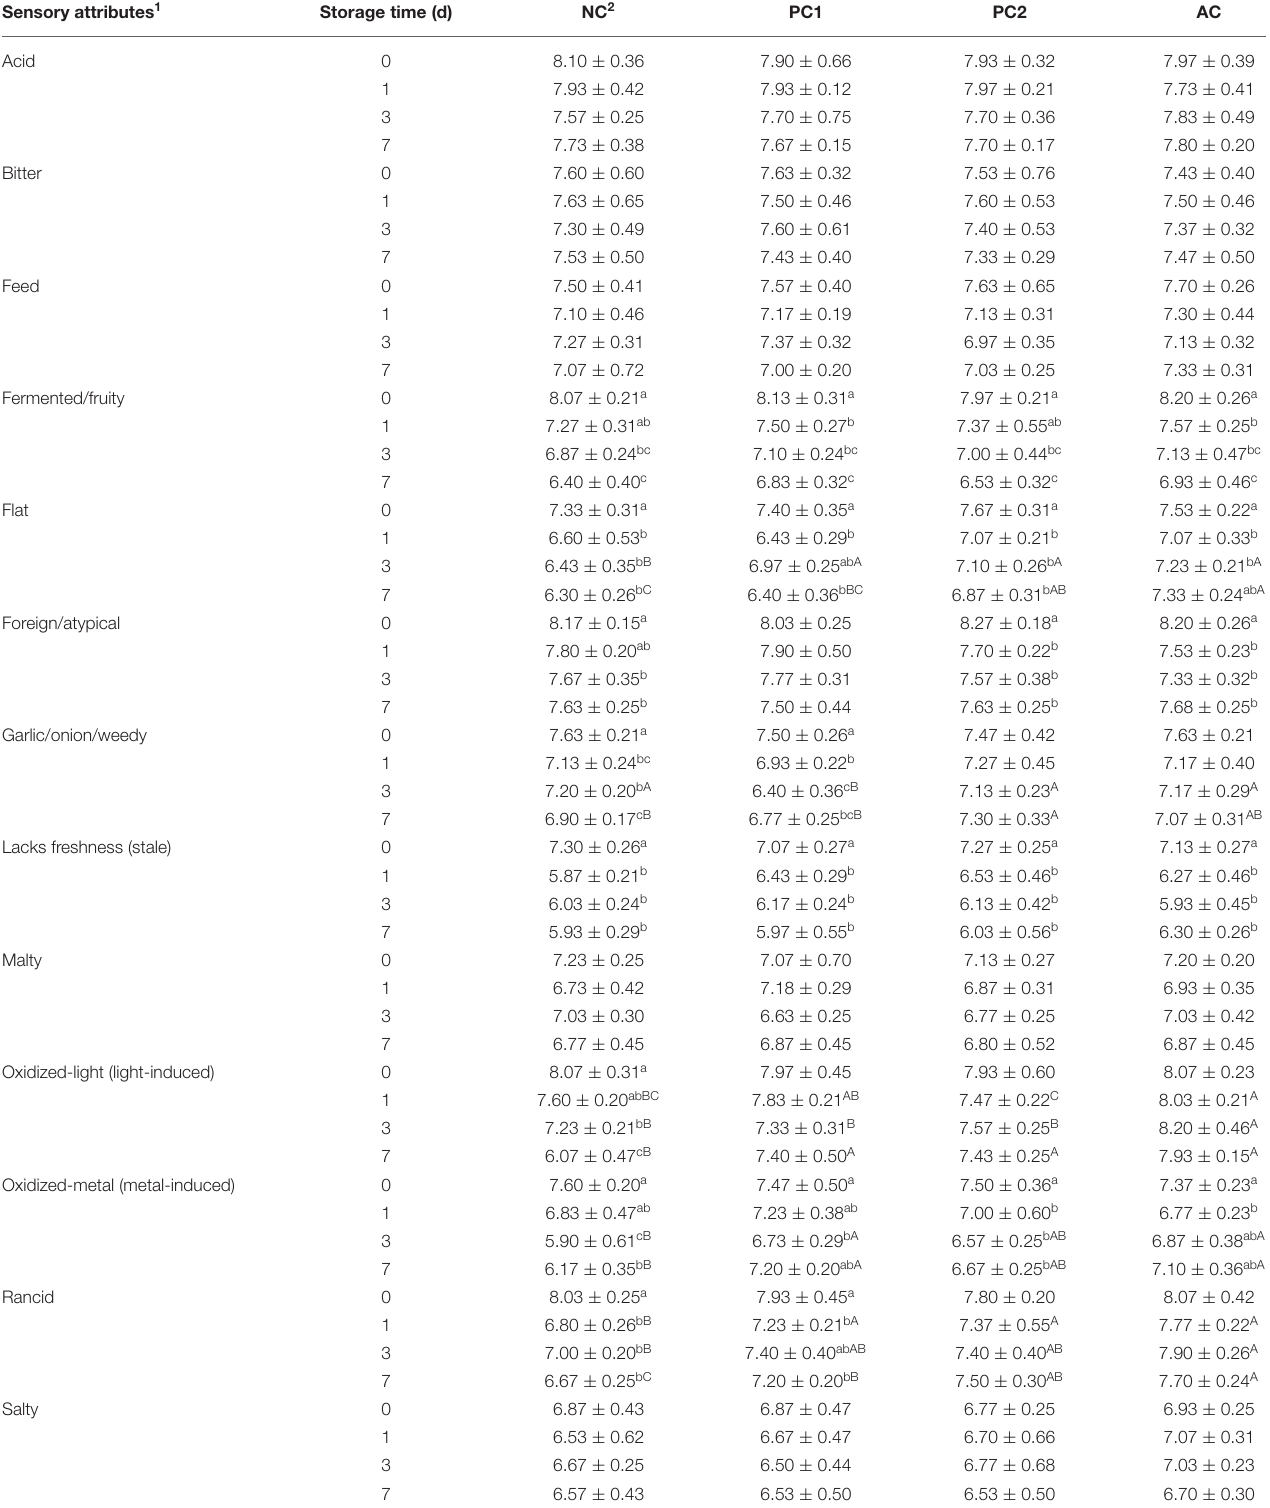
TABLE 7 | Effect of PCP on sensory scores in milk during storage period. Sensory attributes